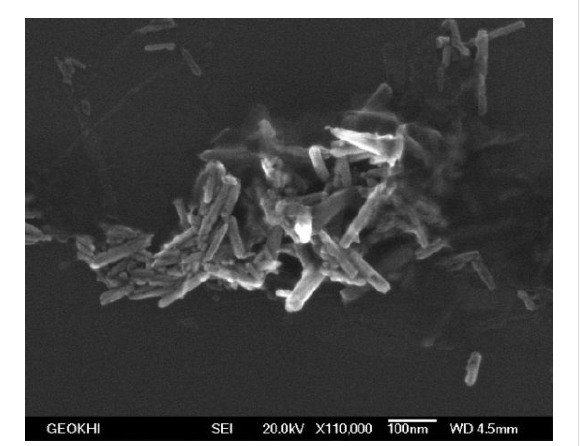
Figure 5: A SEM image of the agglomerates of ZnO NPs in the suspension 1 h after the discharge. The scale bar is 100 nm.